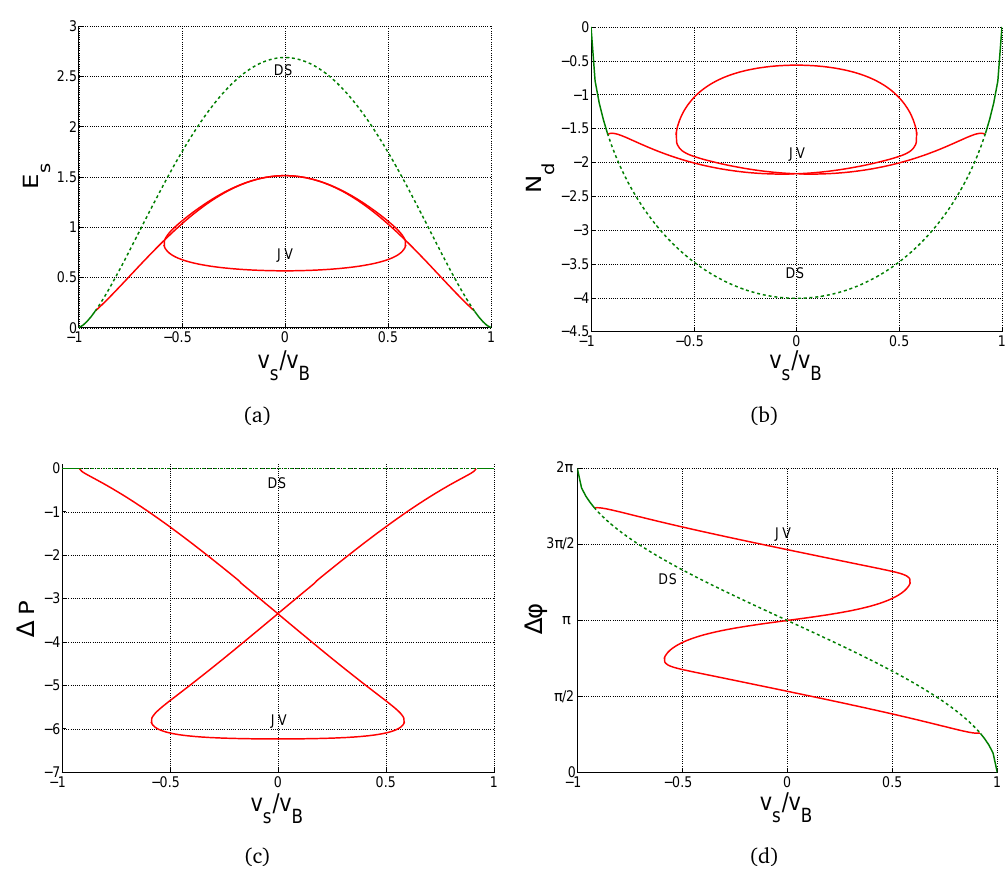
Figure 7: No cross-interaction, weak coupling regime ( γ = 1, ν = 0.005). Energy (a), missing particle number (b), angular momentum (c) and phase difference (d) as a function of velocity. Properties of Josephson vortices (labeled ‘JV’) are plotted in red and those of dark solitons (labeled ‘DS’) in green. Solid lines indicate stable solutions, while dashed lines depict unstable